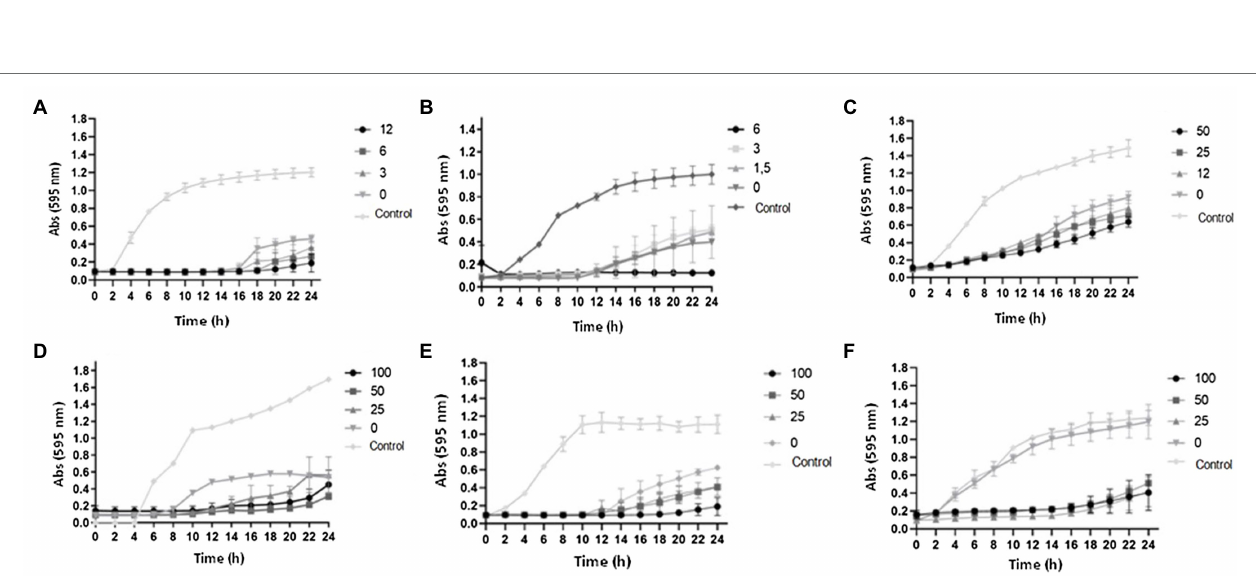
FIGURE 7 | Growth curves of bacteria treated with phenolic compounds and kanamycin. (A) A. hydrophila IOC/FDA 110-36 treated with curcumin (0, 3, 6, and 12 μ M) and kanamycin (256 μ g/ml). (B) Salmonella Montevideo 163 treated with curcumin (0, 1.5, 3, and 6 μ M) and kanamycin (32 μ g/ml). (C) Serratia marcescens MG1 treated with curcumin (0, 12, 25, and 50 μ M) and kanamycin (32 μ g/ml). (D) A. hydrophila IOC/FDA 110-36 treated with resveratrol (0, 25, 50, and 100 μ M) and kanamycin (128 μ g/ml). (E) Salmonella Montevideo treated with resveratrol (0, 25, 50, and 100 μ M) and kanamycin (32 μ g/ml). (F) Serratia marcescens treated with resveratrol (0, 25, 50, and 100 μ M) and kanamycin (4 μ g/ml). Control = bacterial growth in LB broth + DMSO